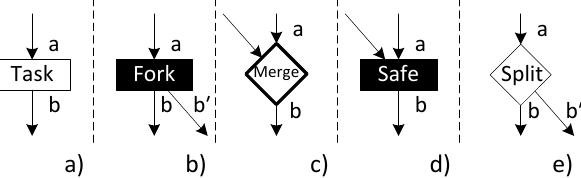
Figure 13. The direct predecessor of an activation edge is also an activation edge, except the node in between is a split